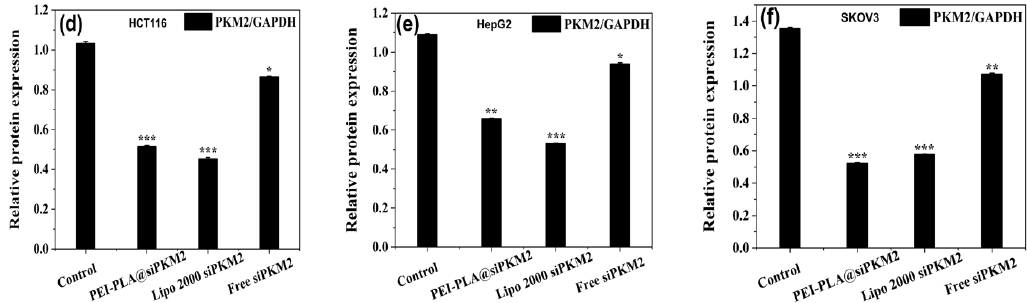
Figure 8. Western blot analysis of PKM2 protein expression in HCT116 ( a ), HepG2 ( b ), and SKOV3 ( c ) cells. GAPDH was used as an internal control. The relative protein expression levels in HCT116 ( d ), HepG2 ( e ), and SKOV3 ( f ) cells were quantified by densitometry. Cells were treated with PEI-PLA@siPKM2 polyplex, Lipo 2000 and free siPKM2 (siRNA concentration: 5 nM) for 48 h. * indicates P < 0.05, ** indicates P < 0.01, and *** indicates P < 0.001, relative to the control cells.